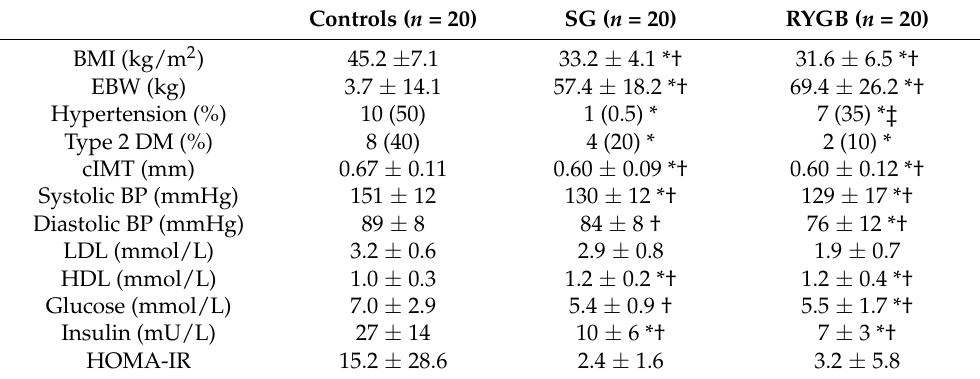
Table 2. Six-month follow-up anthropometric and metabolic characteristics of the men included in this